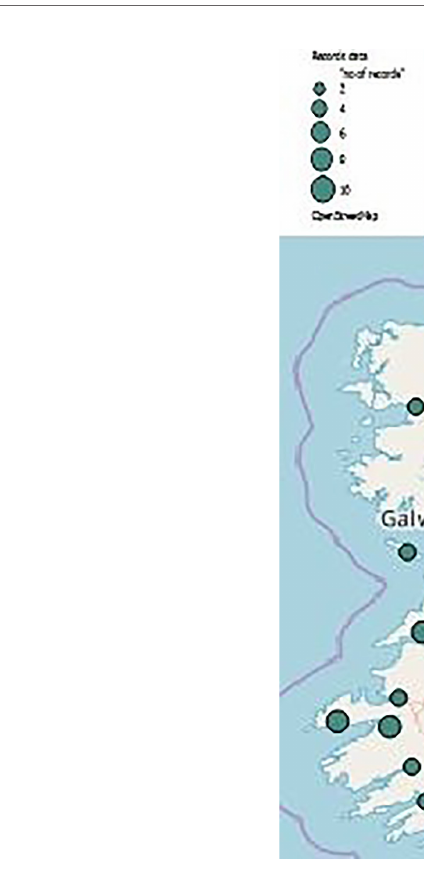
Chilocorus renipustulatus ( Figure 4 ). Between April 2020 and June 2021, we recorded 36 records for these two species compared to 69 records reported by the national data base.